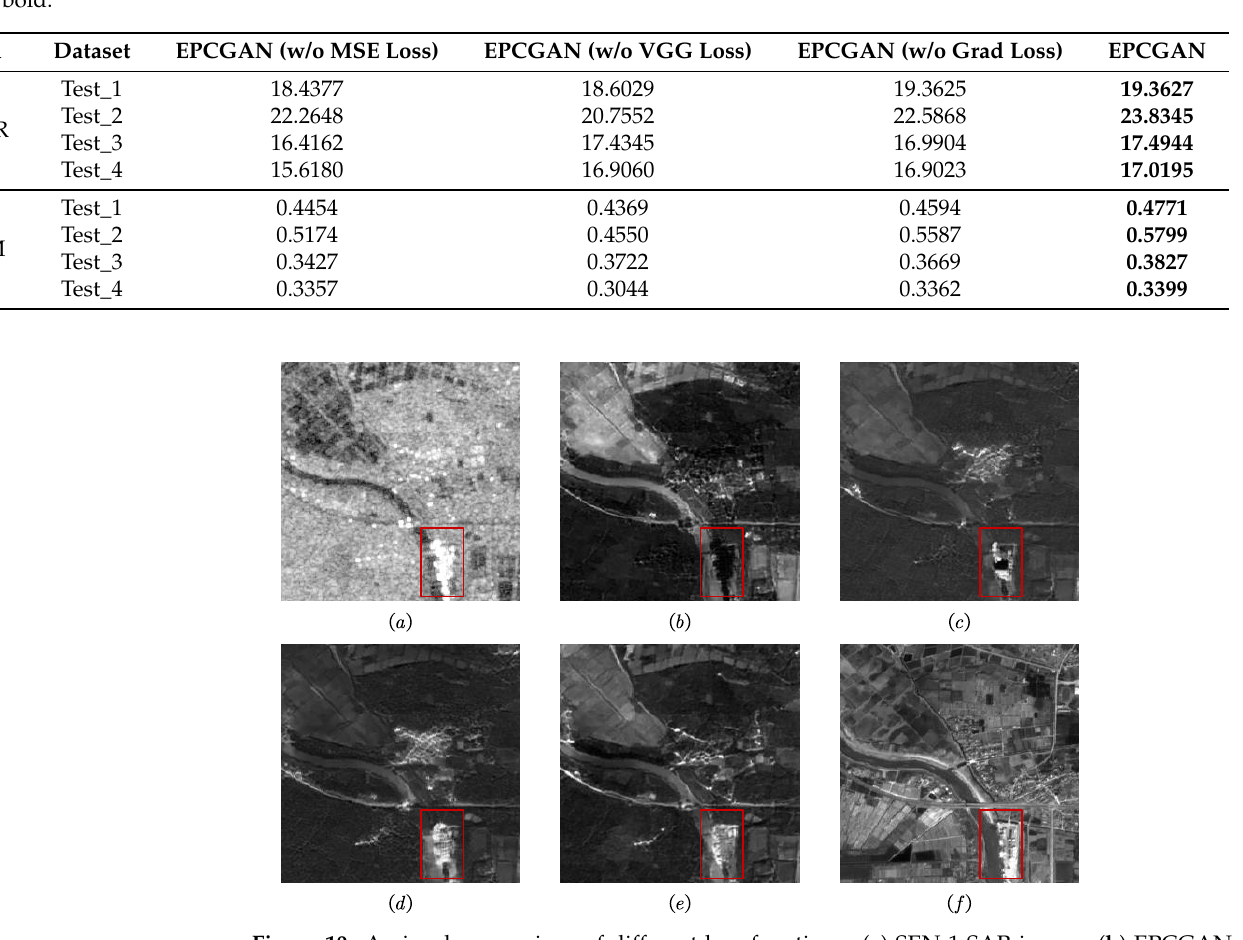
Figure 10. A visual comparison of different loss functions. ( a ) SEN-1 SAR image. ( b ) EPCGAN (without MSE loss). ( c ) EPCGAN (without VGG loss). ( d ) EPCGAN (without grad loss). ( e ) EPCGAN. ( f ) SEN-2 optical